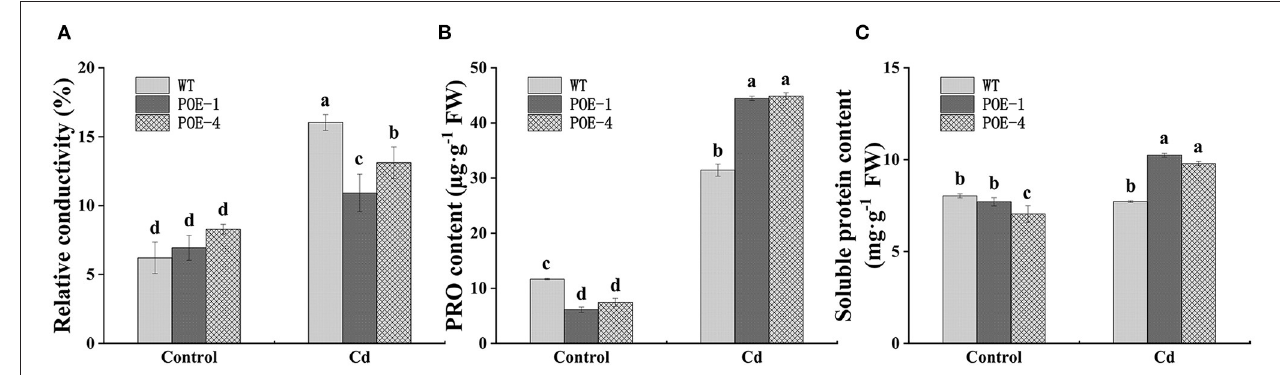
FIGURE 7 | PscCYP716A1 improves the osmotic pressure adjustment capacity of poplar under Cd stress. (A) Relative conductivity. (B) Free proline content. (C) Soluble protein content. All data are the mean ± SD of three biological duplicates. Significant differences between treatments are indicated by different small letters ( p <